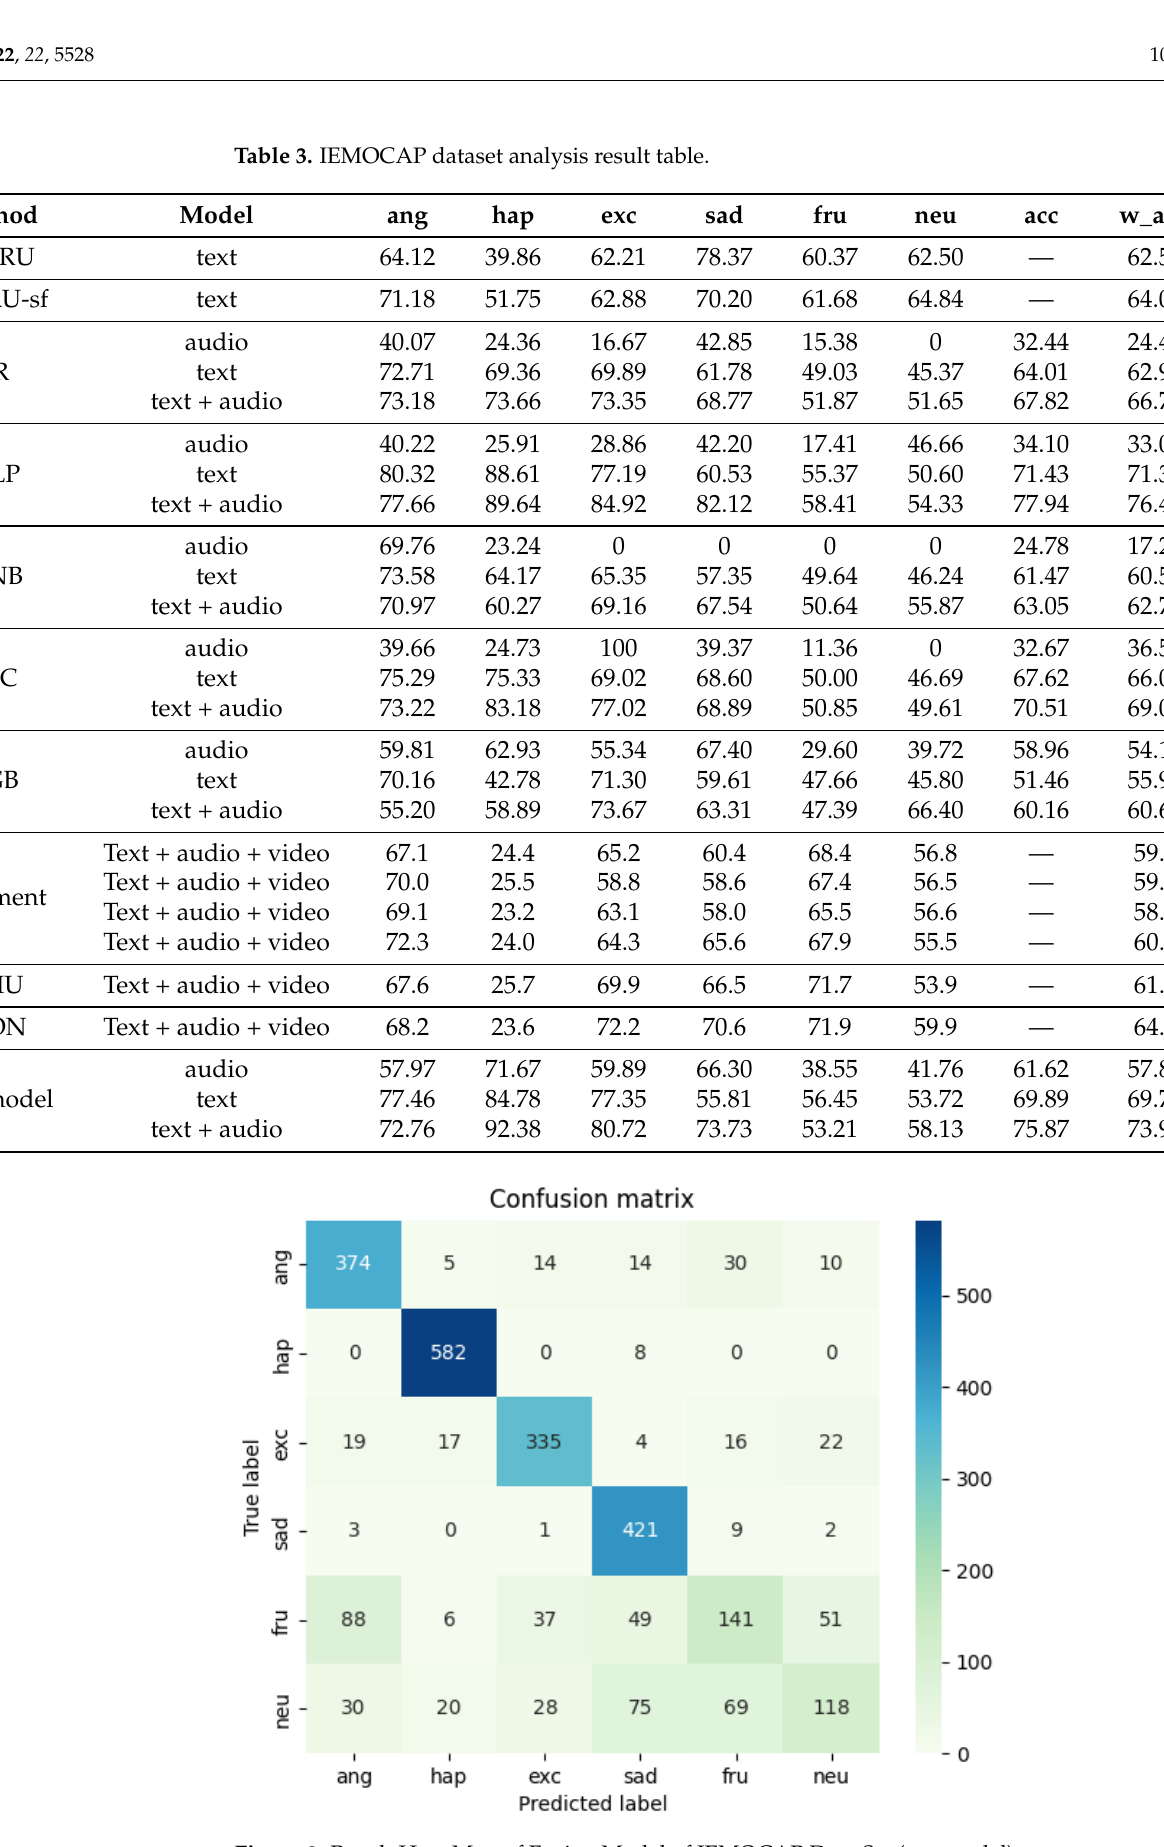
Figure 9. Result Heat Map of Fusion Model of IEMOCAP Data Set (out